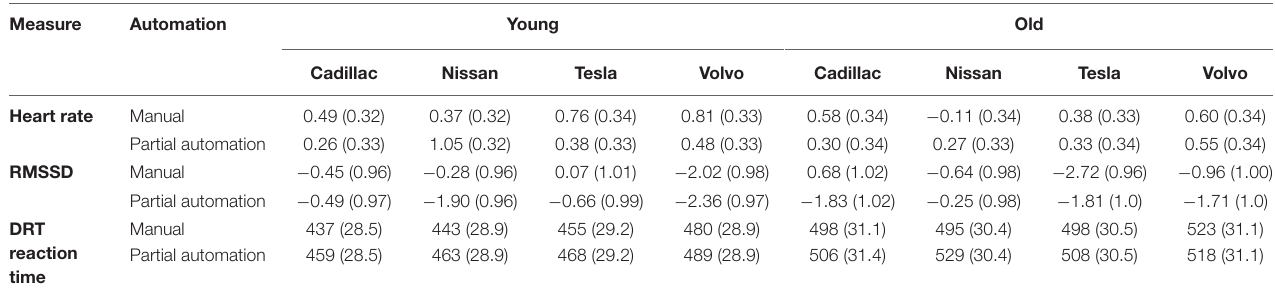
TABLE 1 | Means (and Standard Error) for heart rate, RMSSD, and DRT reaction time as a function of automation (manual and partial automation), age (younger or older), and vehicle (Cadillac, Nissan Rogue, Tesla, and Volvo).